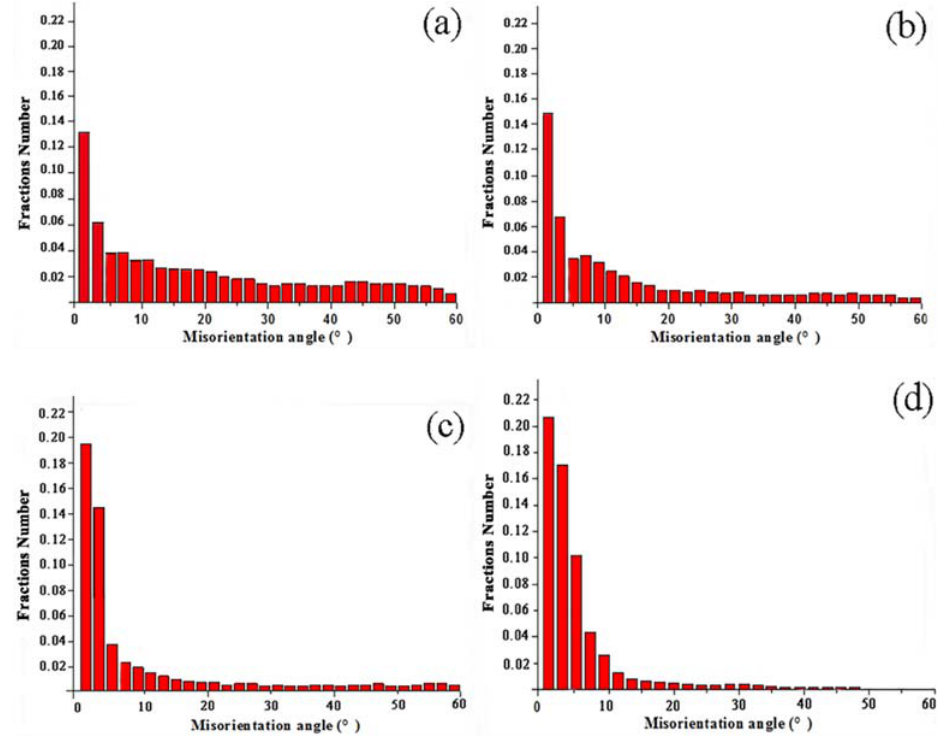
Figure 5. The grain misorientation angles of 6061 aluminum alloys. ( a ) MEM; ( b ) MEE; ( c ) 3 ‐ pass of ECAP; ( d ) 3 ‐ pass of MAC.